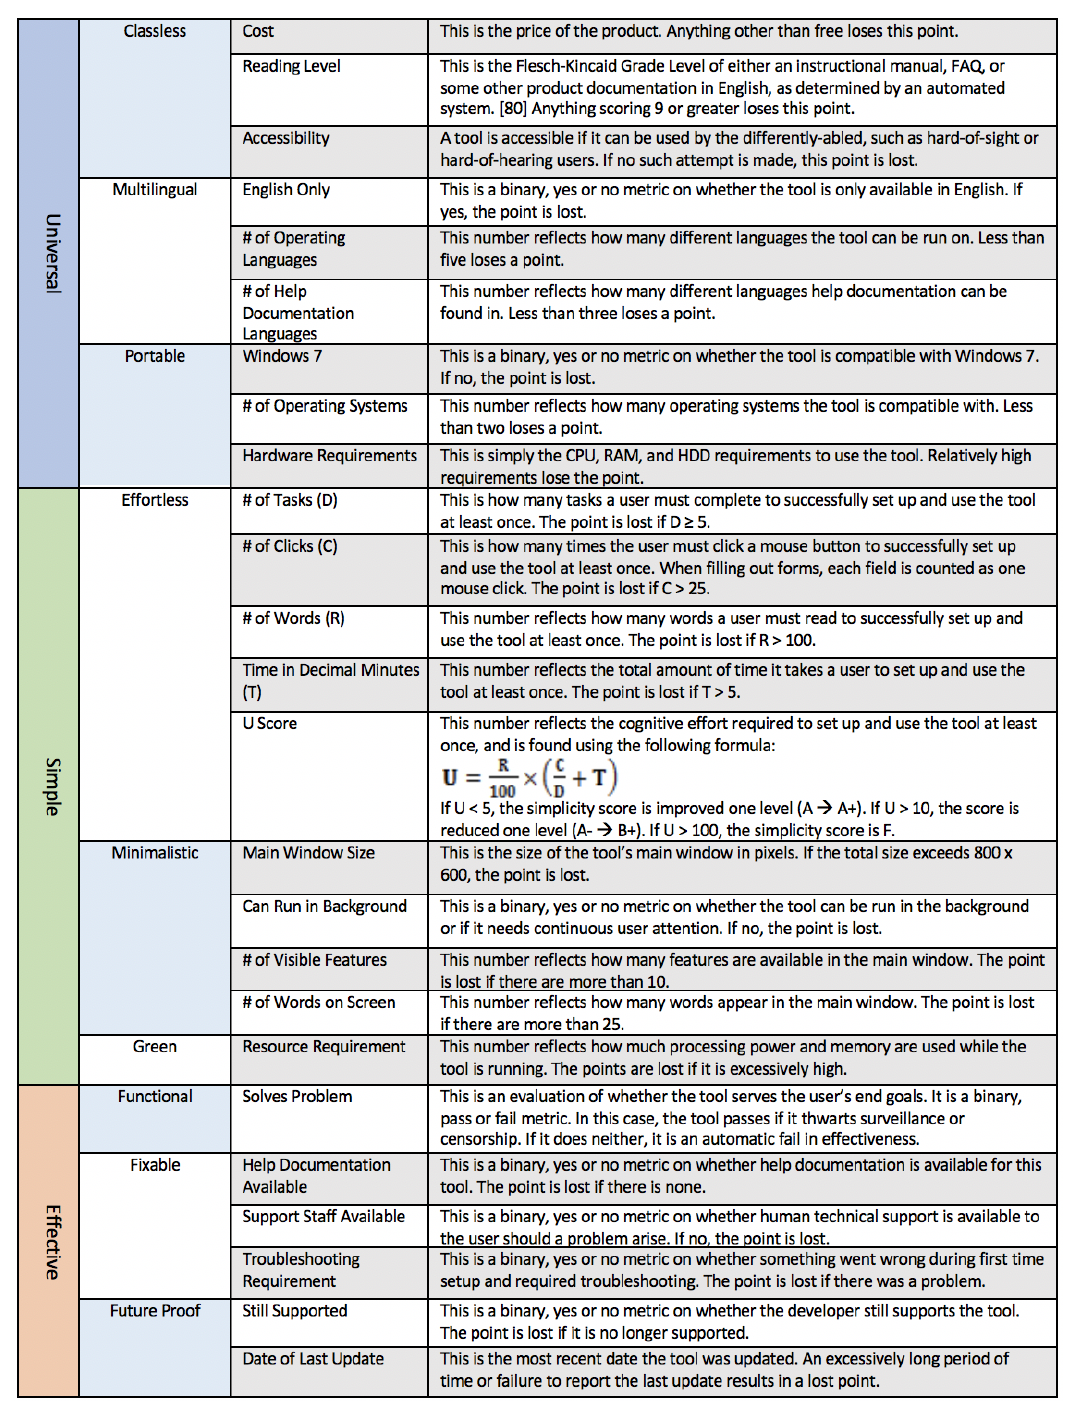
Figure 6. Parameters for our